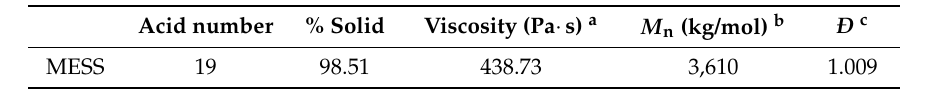
Table 1. Properties of MESS.